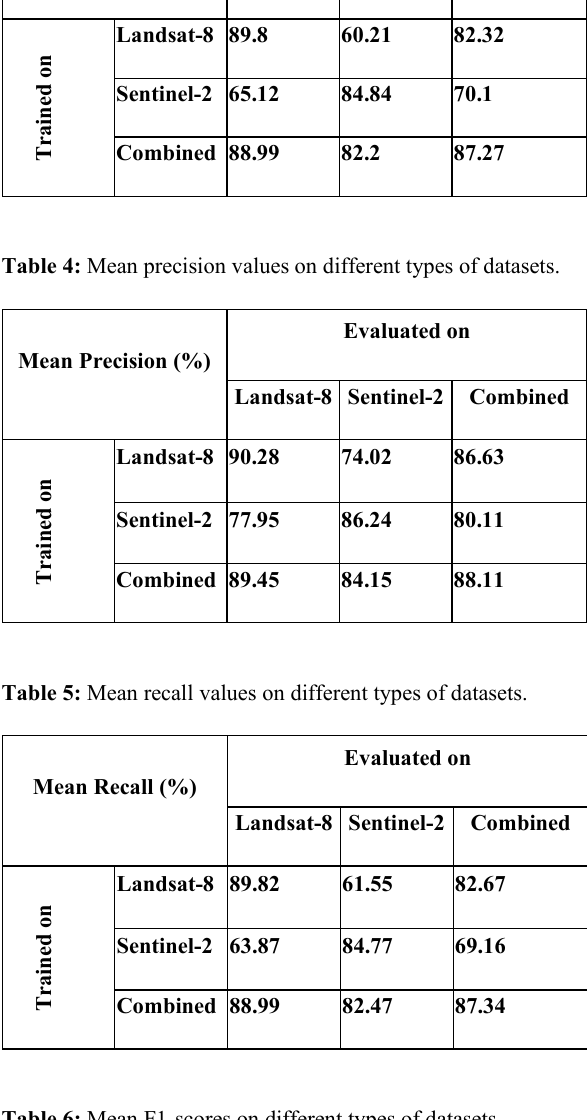
Table 6: Mean F1-scores on different types of